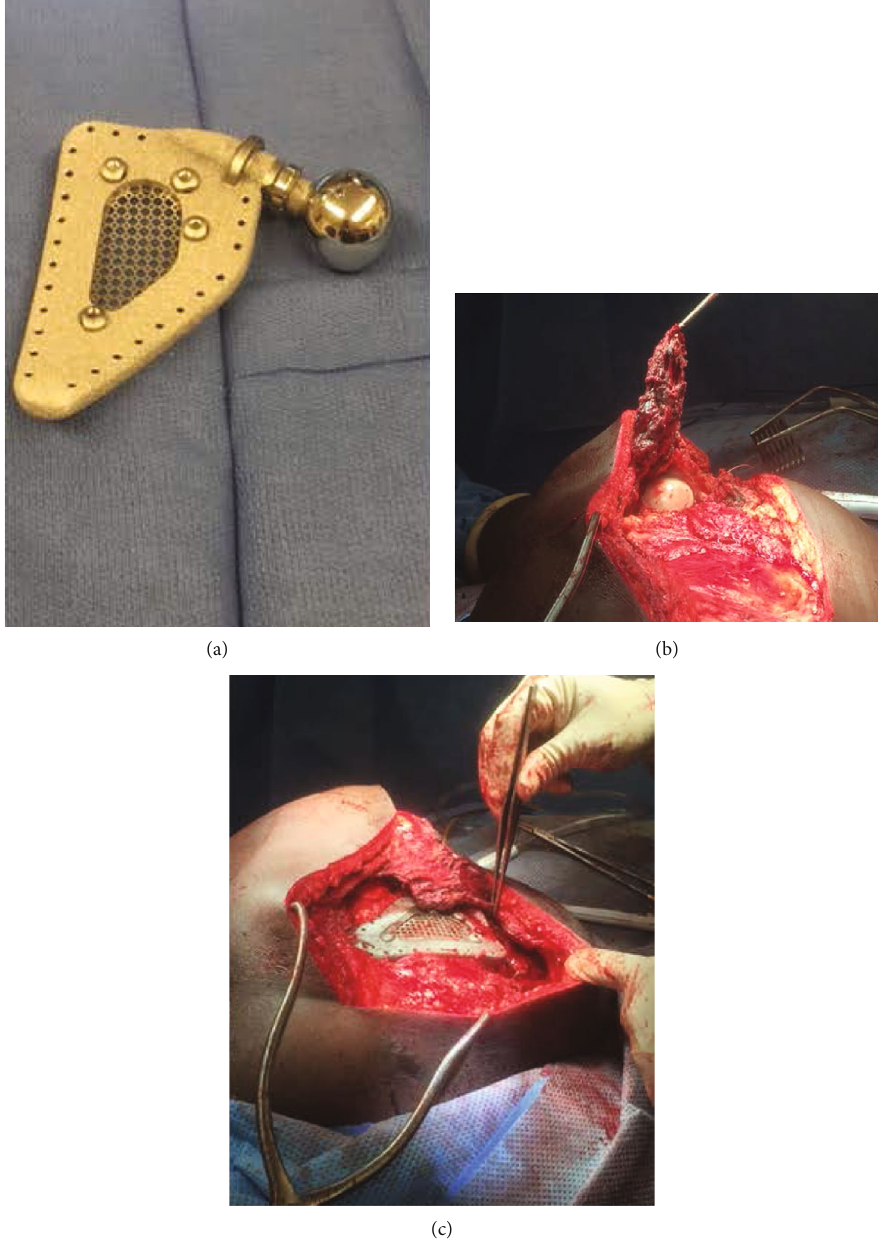
Figure 4: (a) Zimmer-Biomet custom total scapula reverse total shoulder prosthesis. (b) Isolation of the periscapular muscle fl aps after excision of the scapula. (c) Incorporation of the soft tissue envelope into the scapular prosthesis through preexisting suture